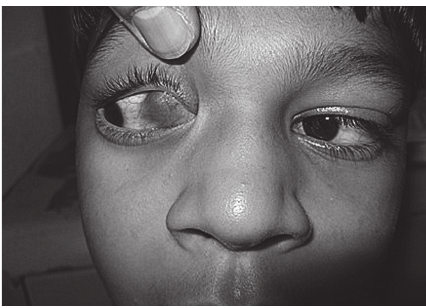
Figure 1: Preoperative status showing prominence of the heman- gioma on dextroversion.